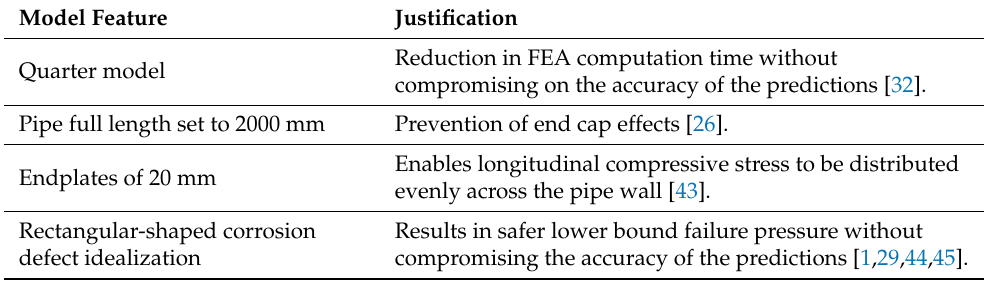
Table 3. Model features and justification.